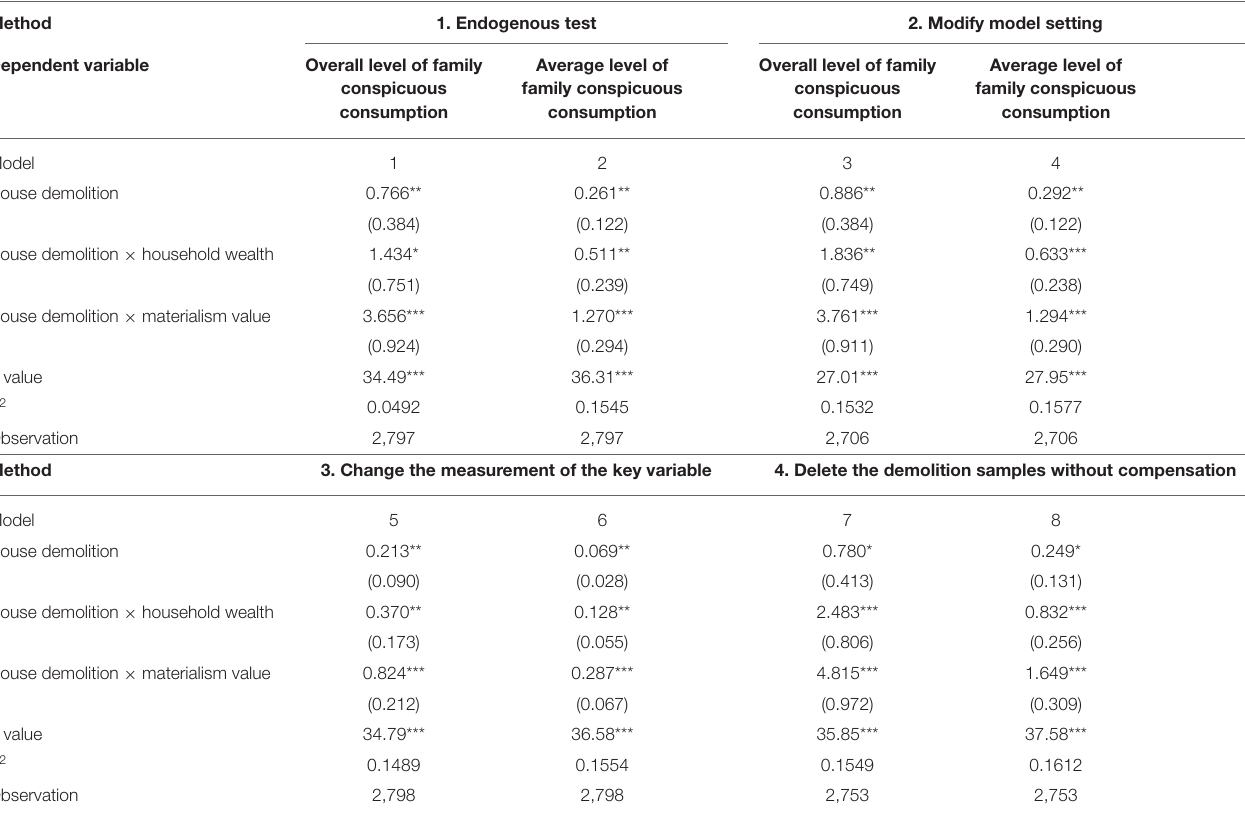
TABLE 3 | Results of the robustness